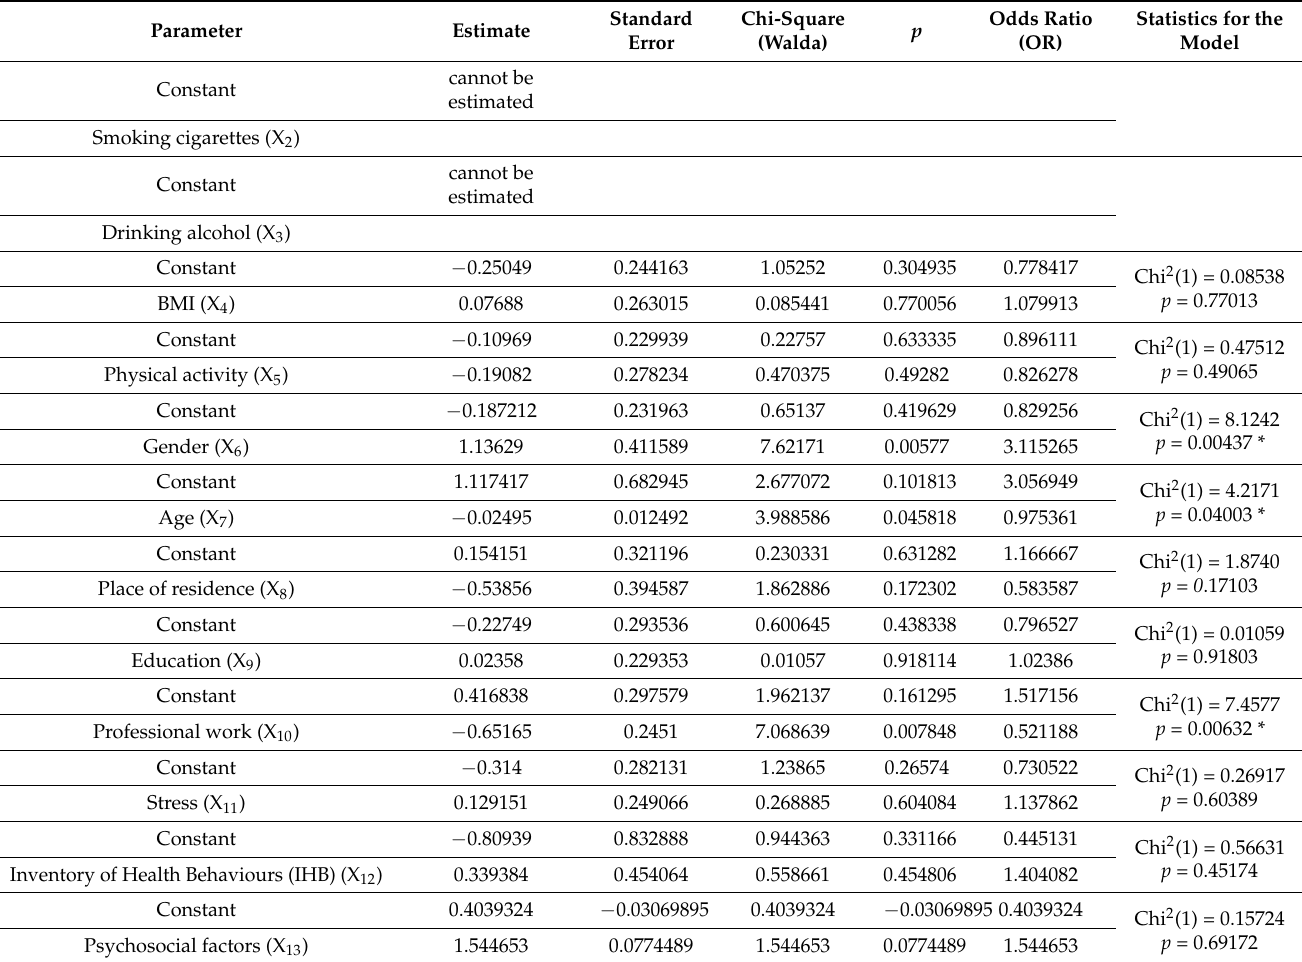
Table 13. Logistic regression score (LRS)—assessment of the relationship between variables considered individually and the probability of an increased homocysteine level for the SDA